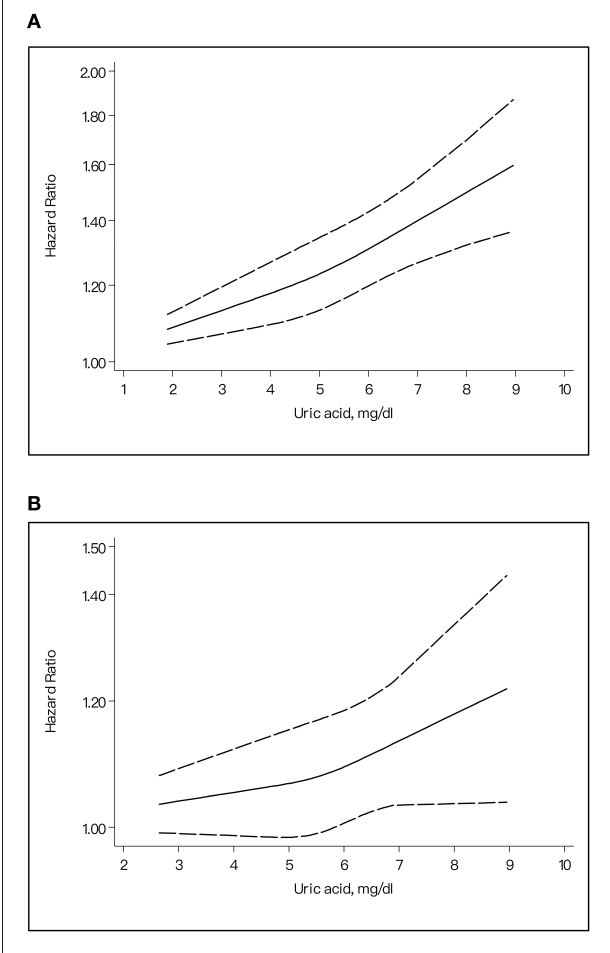
FIGURE 5 | The dose-response plot on the association of uric acid levels and risk of stroke for different gender. (A) Female. (B) Male.